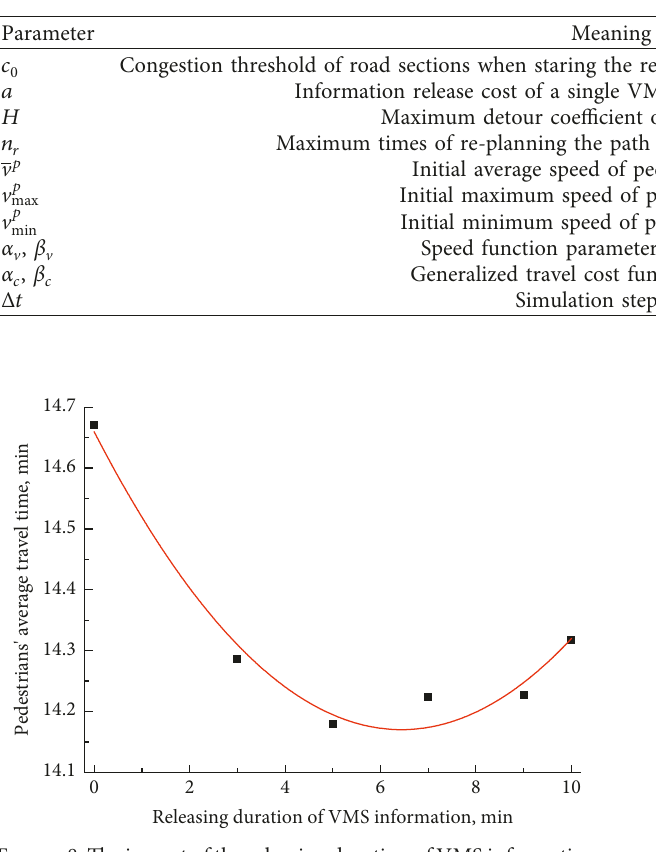
Table 2: Other simulation parameters.